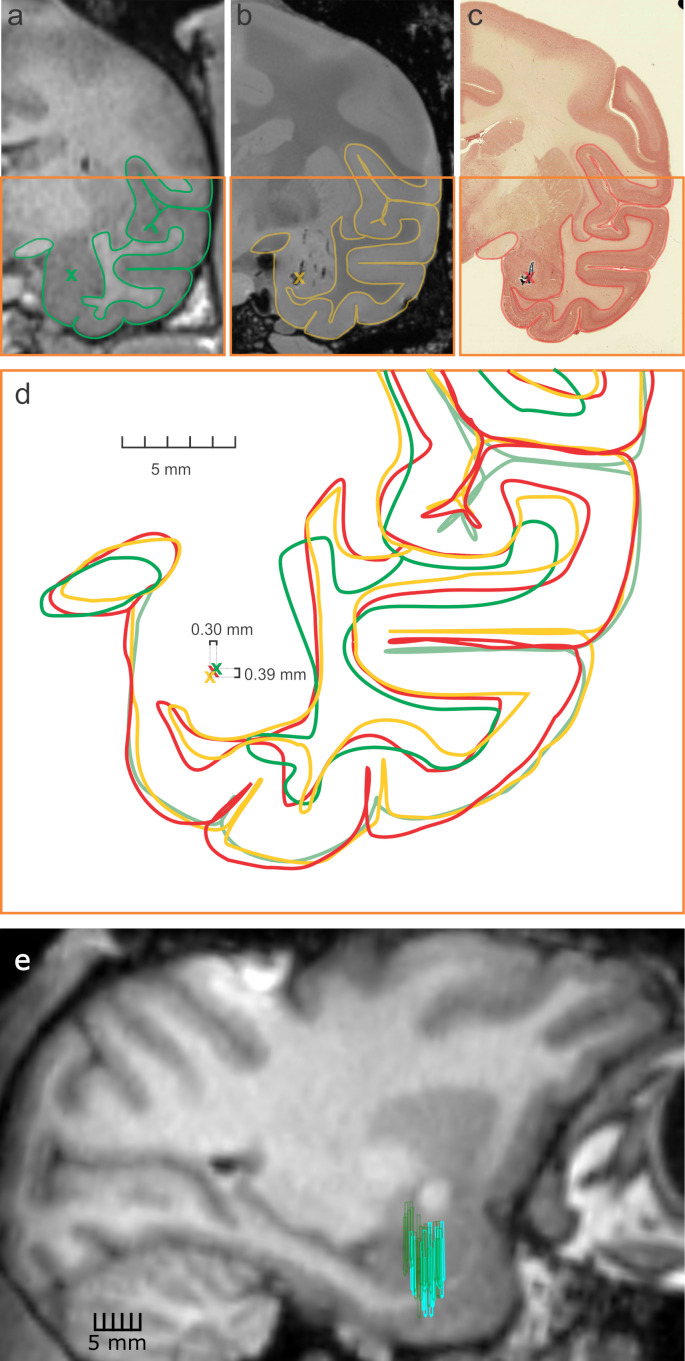
Histological verification of electrode placement.(a) Coronal slice from a 3T MRI scan of the right hemisphere of the brain of monkey B at the location of a dye injection into the amygdala. The MRI scan was taken after the surgical implant of the recording chamber. The green X indicates the predicted site of a cell stain injected immediately preceding euthanasia and perfusion (4% PFA) of the brain. The targeting of the injection site and the estimated locations of the contacts were both calculated relative to the same stereotaxic coordinates used for initial implantation of the recording chamber. (b) Coronal slice from an ex vivo, high-resolution 7T MRI. The scan was performed on the brain of monkey B ten weeks after perfusion and provided a more detailed visualization of the injection prior to histological processing. The gold X indicates the position of the dye injection. Note that electrode tracks can be seen dorsal and lateral to the injection site. (c) Histological verification of injection site estimates on a neutral-red stain. The red X indicates the position of the dye injection. (d) The estimated locations of the dye injection site along with the boundaries of major temporal lobe structures (contained in the orange boxes in a–c) from the three images were overlaid. The numbers around the injection site reconstructions (i.e., the X’s) indicate the distances between the centers of the farthest separated sites (green and gold) in the dorsal-ventral (0.39 mm) and medial-lateral (0.30 mm) axes. These distances show that even when taking the largest differences in estimated injection location, the dorso-lateral and ventral-medial error is less than the space between two contacts on the V-probe. (e) Projection of all estimated array positions from recordings in monkeys B (cyan) and F (green) onto a single sagittal slice from a 3T MRI scan of the brain of monkey B.